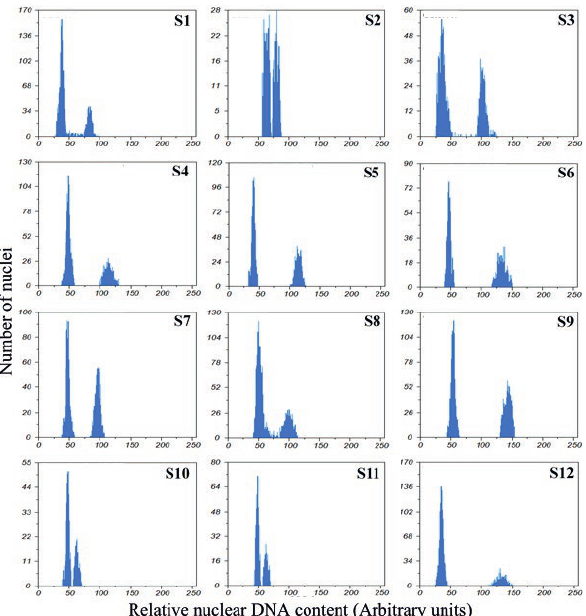
Figure 7. Histograms of relative fluorescence intensity were obtained, using WPB isolation buff er aft er simultaneous analysis of nuclei isolated from standard plant and berry species plants. Th e mean channel number and coeffi cient of variation (CV%) value of each peak are also